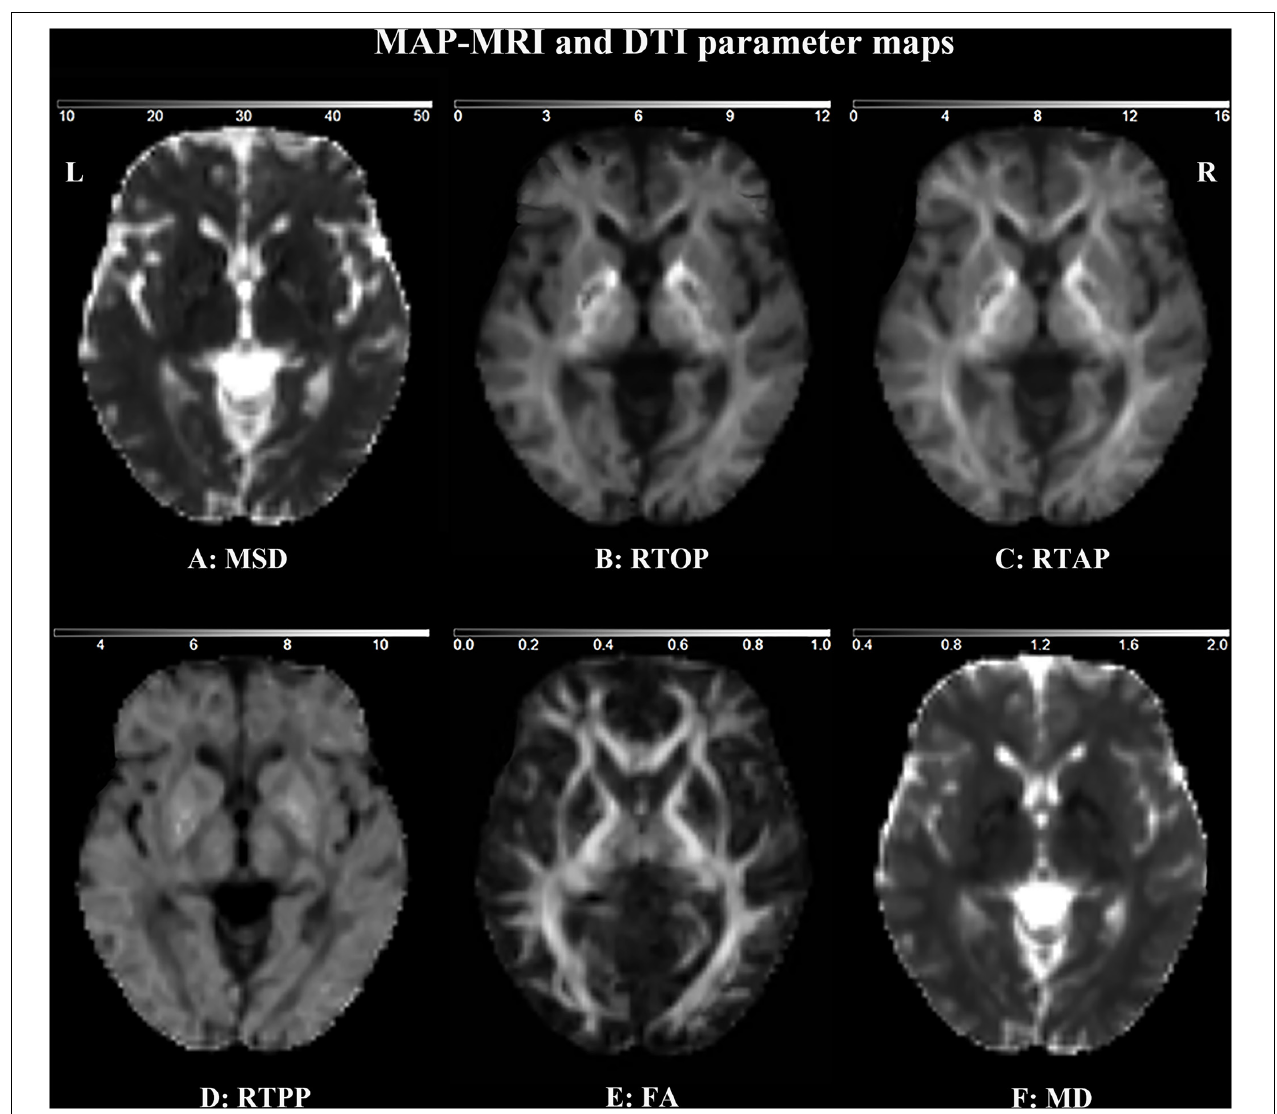
FIGURE 3 | MAP MRI and DTI parameter maps of a representative healthy subject. MSD (A) , RTOP (B) , RTAP (C) and RTPP (D) are derived from MAP MRI, and FA (E) , and MD (F) are derived from DTI. FA is dimensionless; MD, MSD, RTOP, RTAP, and RTPP are expressed in 10 − 3 mm 2 s − 1 , 10 − 5 mm 2 , 10 5 mm − 3 , 10 3 mm − 2 , and 10 1 mm − 1 ,